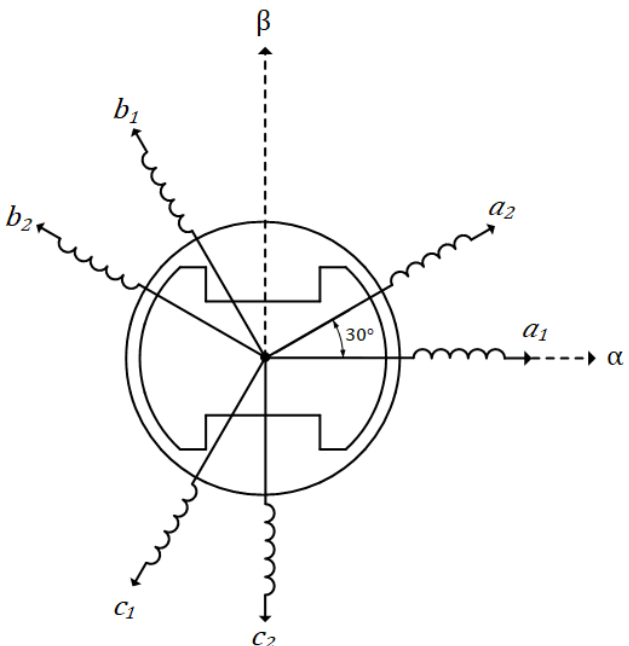
Figure 6. Reference configuration for coupled transformations.